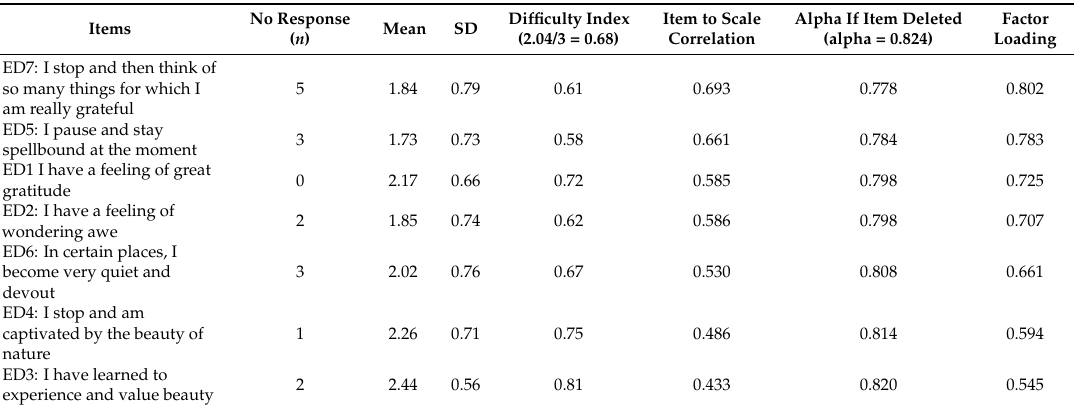
Table 2. Reliability and factorial